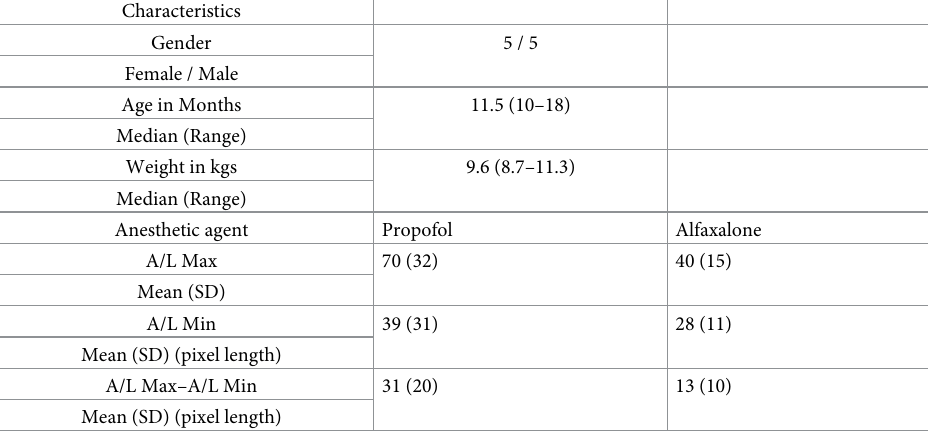
Table 1. Summary of study objects and study outcome of A/L